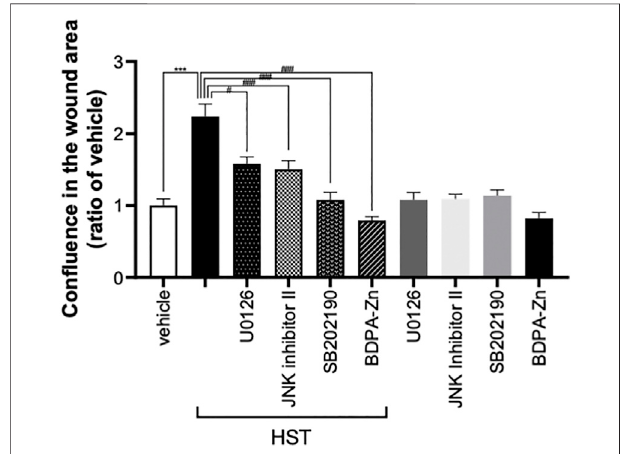
FIGURE1| EffectofMAPKinhibitorsonHangeshashinto(HST)-induced migration of human oral keratinocyte (HOKs). HOKs were scratched and co- treated with HST, CXCR4 inhibitor BDPA-Zn, ERK inhibitor U0126, JNK inhibitor II, or p38 inhibitor SB202190 for 72 h. Data are expressed as the mean ± SEM (bars, n (cid:2) 12 – 50). *** indicates p < 0.001, compared with vehicle; #, ##, #### indicates p < 0.05, p < 0.01, p < 0.001 compared with HST alone. Bonferroni ’ s comparison test following